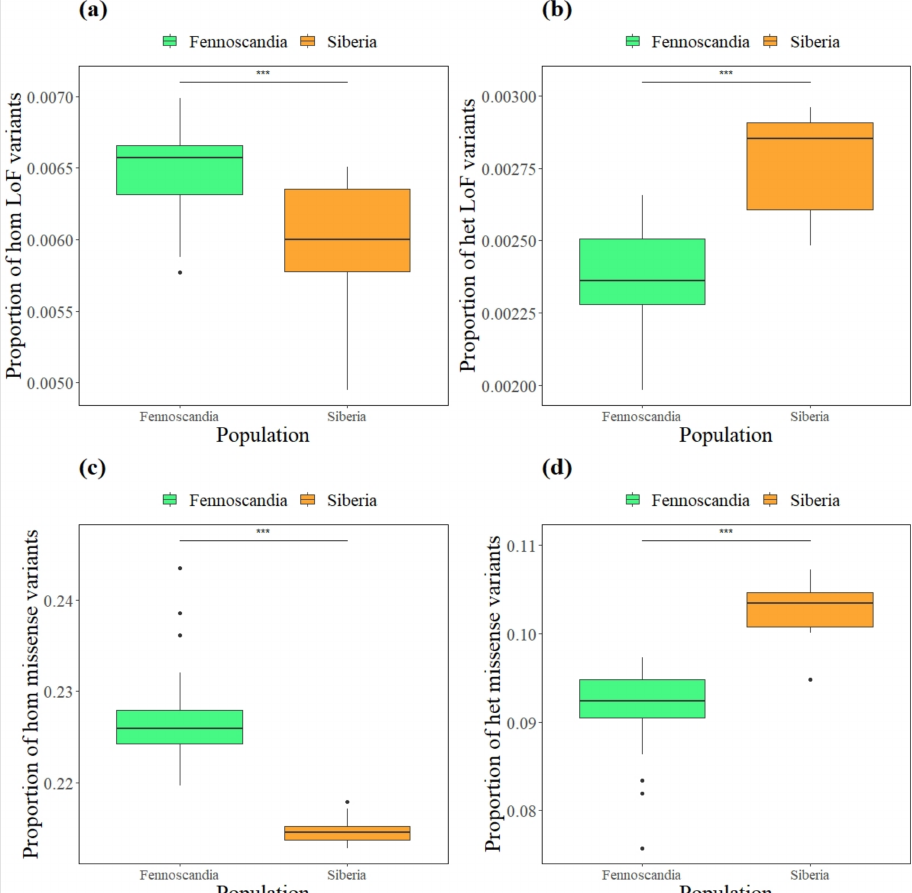
Figure 6. Proportion of deleterious variants in arctic foxes of the northern Fennoscandian and Siberian populations; separated into ( a ) homozygous loss of function variants (LoF), ( b ) heterozygous LoF variants, ( c ) homozygous missense variants, and ( d ) heterozygous missense variants. Proportion calculated as the number of each variant type divided by total variants. The horizontal bar shows the median, the boxes show the 25–75% interquartile range and the whiskers show the whole range. Significant results marked with *** P <